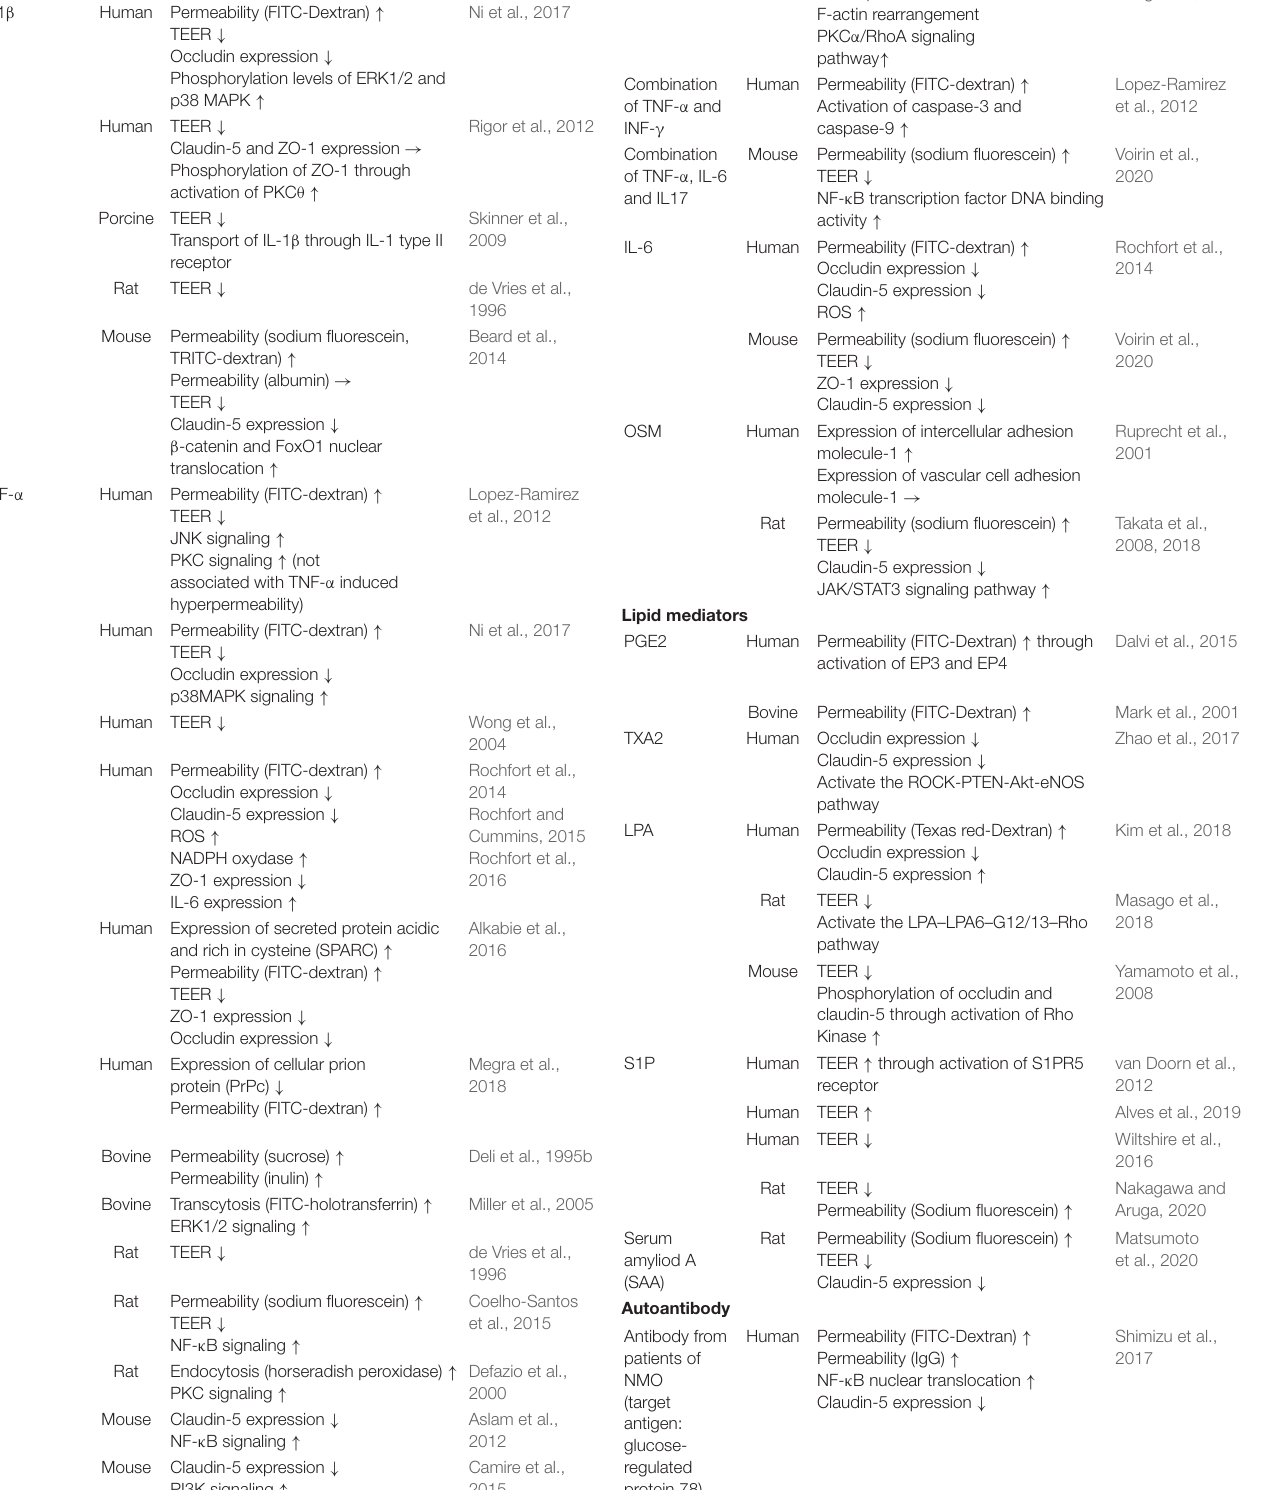
TABLE 1 | Inflammatory mediators involved in BBB dysfunction and related cellular events in